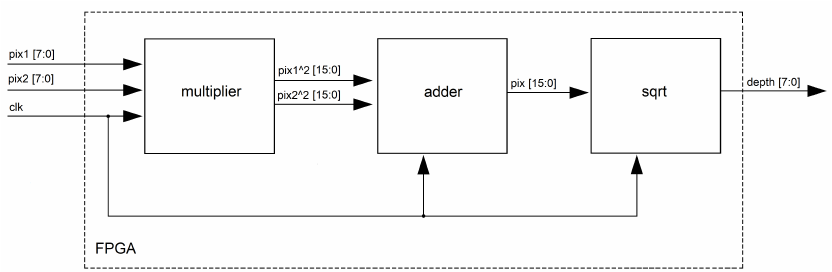
Figure 13. FPGA architecture for the “depth estimation”